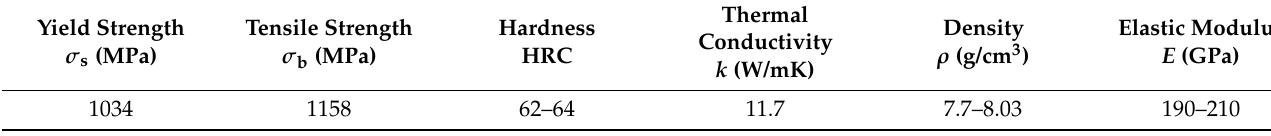
Table 1. Physical and mechanical properties of 20MnCr5.